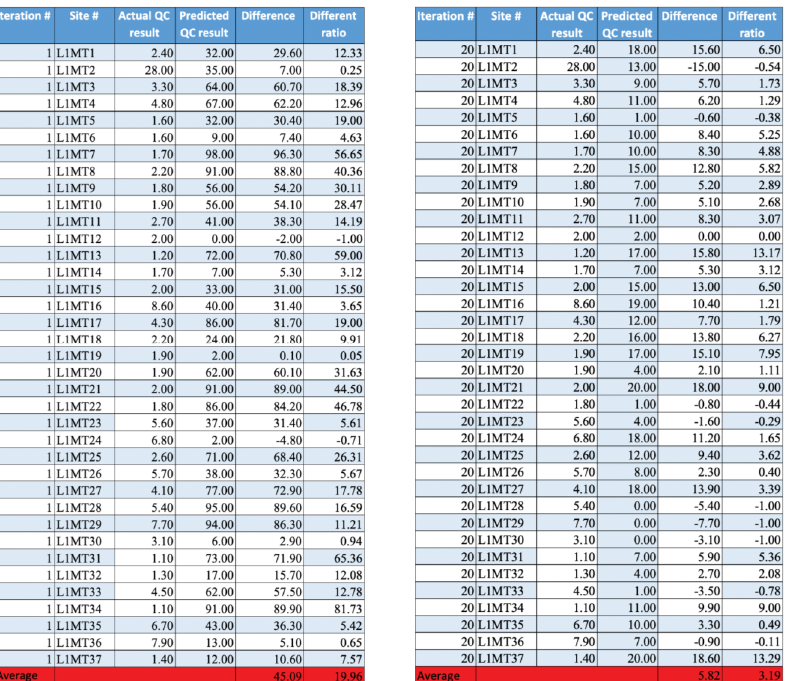
Figure 16. Summary result comparison BP artificial network training for quality assurance of magnetotelluric data. The training results of first iteration are on the left. The average difference is 45.09 and average different ratio is 19.96. The training results after 20 iterations are on the right with an average difference of 5.82 and average difference ratio of 3.19. It shows that our BP network is getting trained and improves with deep learning.